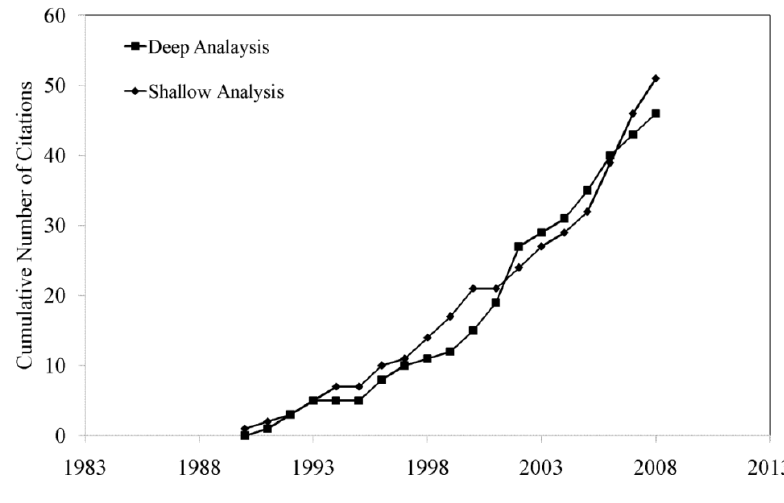
Figure 6. “Depth of conceptual application in citing